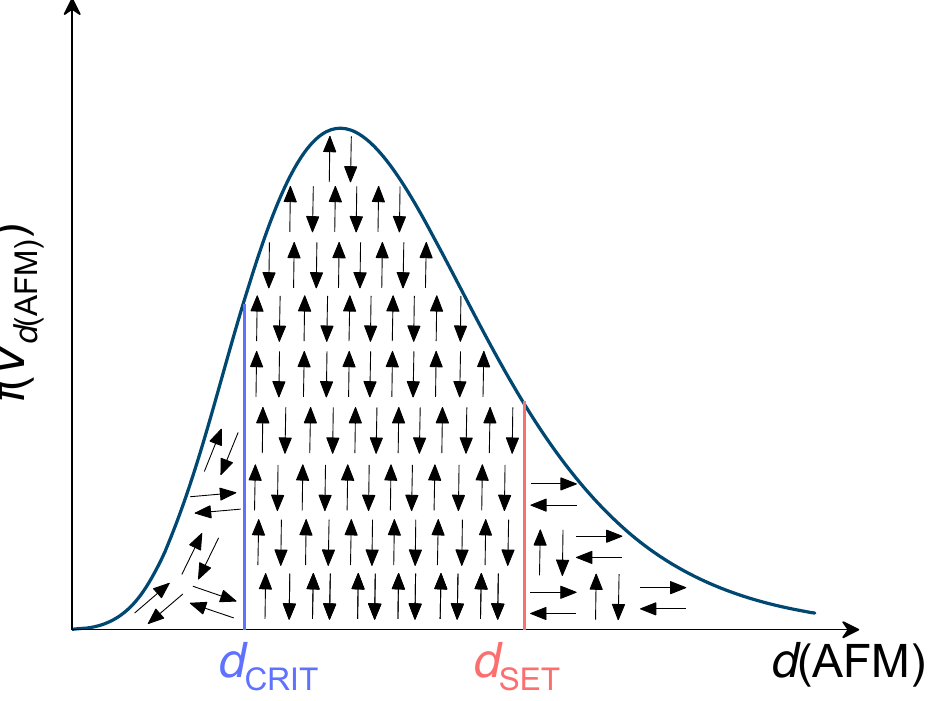
Figure 6. Schematic representation of an antiferromagnetic grain size (V d (AFM)) distribution after inducing of magnetic anisotropy.